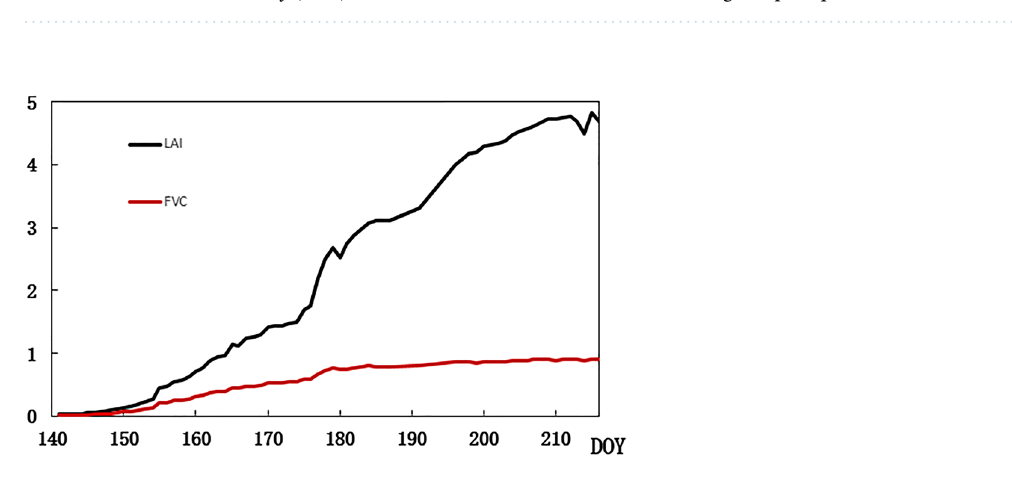
Figure 7. Change curve of LAI and FVC in site